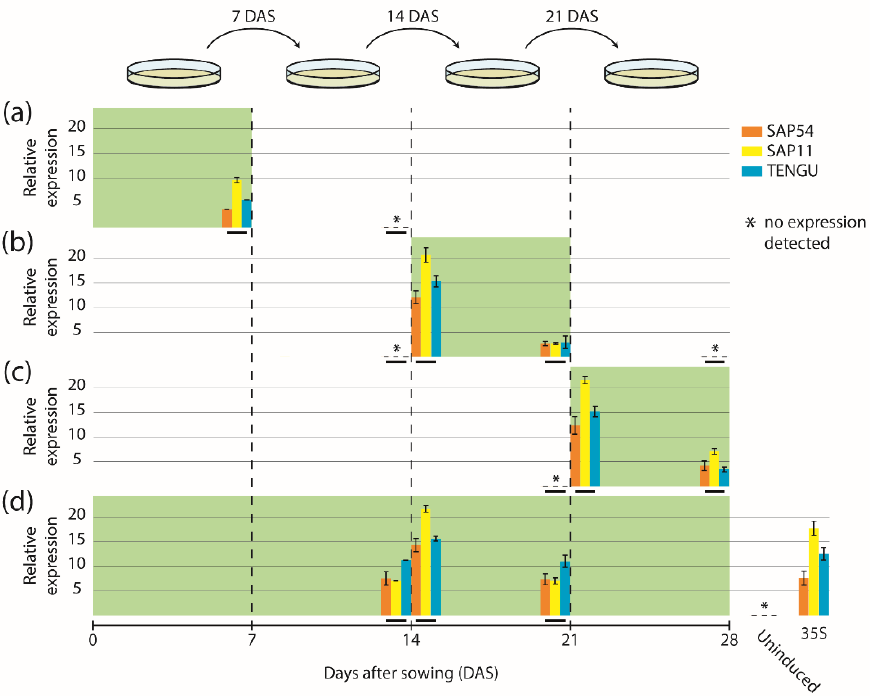
Figure 2. Expression time-course of mGFP6-SAP54, mGFP6-SAP11 and mGFP6-TENGU mRNAs. Arabidopsis LexA::mGFP6-SAP54, LexA::mGFP6-SAP11, and LexA::mGFP6-TENGU plants